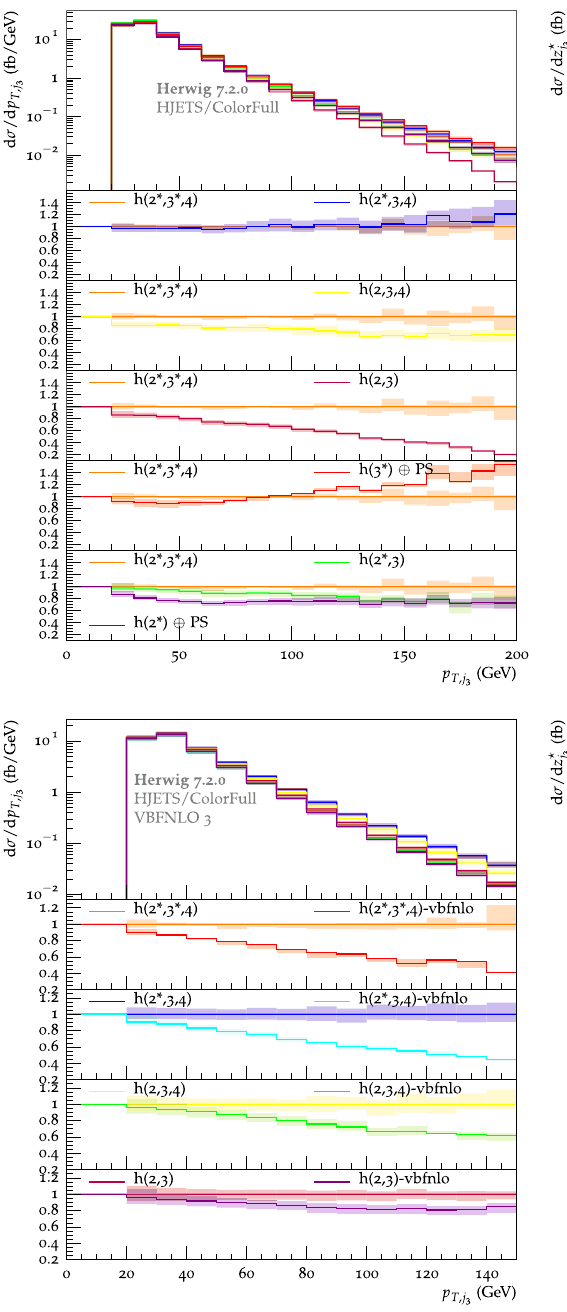
Fig. 7 Shown are kinematic distributions in the transverse momen- to the h ( 2 (cid:3) , 3 (cid:3) , 4 ) prediction (INCL selection cuts). In the bottom row tum of the third leading jet p T , j we compare the merged setups using VBFNLO MEs against the setups (left column) and Zeppenfeld variable 3 z (cid:3) (right column). In the top row predictions h ( 2 (cid:3) , 3 (cid:3) , 4 ) , h ( 2 (cid:3) , 3 , 4 ) , using HJets MEs using LOOSE selection cuts. Shown in the figures (cid:2) (cid:2) j 3 aretheory error bands due tothevariation ofthe factorizationand renor- h ( 2 , 3 , 4 ) , h ( 2 (cid:3) , 3 ) , h ( 2 , 3 ) , h ( 3 (cid:3) ) PS,and h ( 2 (cid:3) ) PSarecompared malization